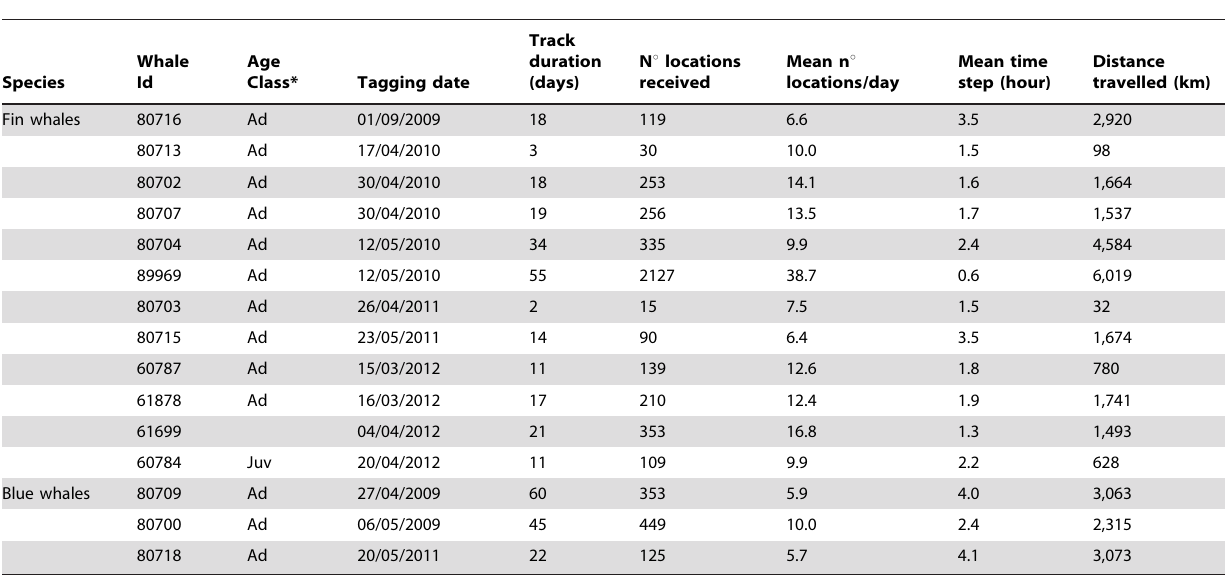
Table 1. Tracking data for fin and blue whales satellite-tagged off Azores from 2009 to 2012.